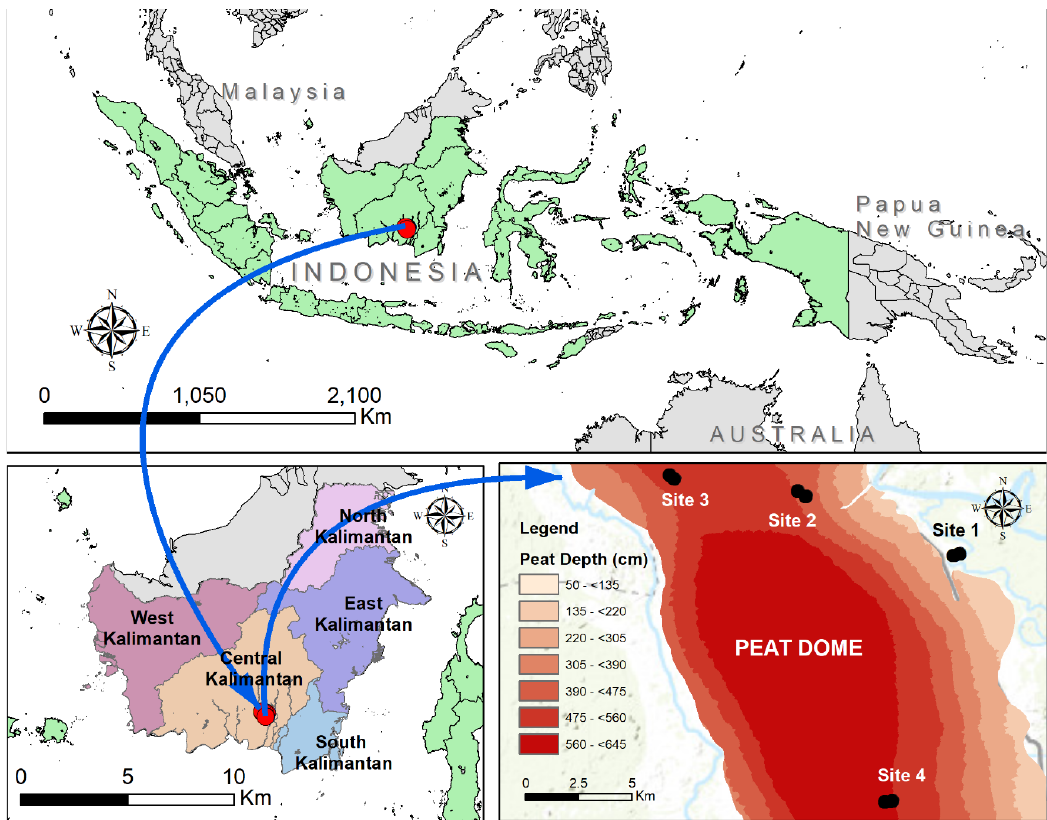
Fig. 1: Geographic location of the study area in the Kahayan Sebangau Peat Hydrology Unit in Indonesia.